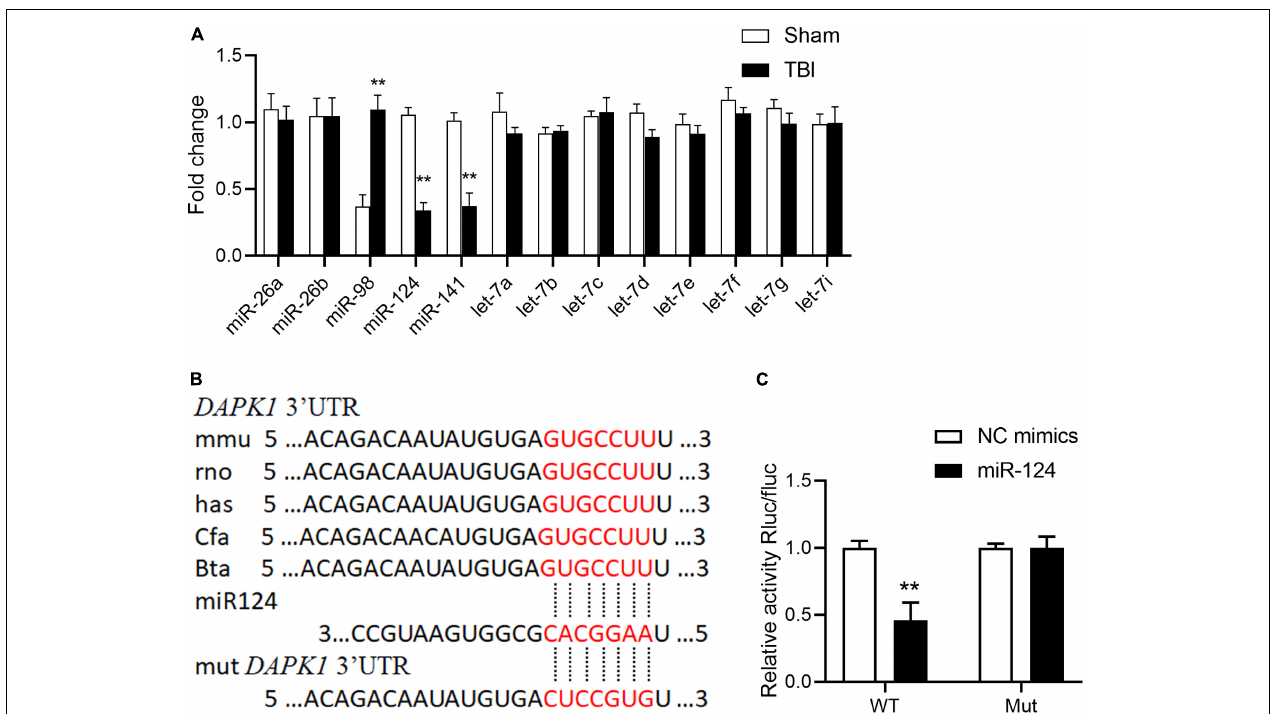
FIGURE 2 | Loss of miR-124 is responsible for DAPK1 elevation in TBI. (A) Alterations in predicted miRNAs that target DAPK1 in the perilesional cortex of sham and TBI mice. (B) The binding sites of miR-124 with DAPK1 are conserved in mammalians. (C) The WT and Mut of DAPK1 were subcloned into the pSI-Check2 vector and transfected into HEK 293T together with miR-124 or NC mimics. The luciferase intensity was measured. n = 3 for each group; ** p < 0.01; Values are presented as the mean ± SEM.